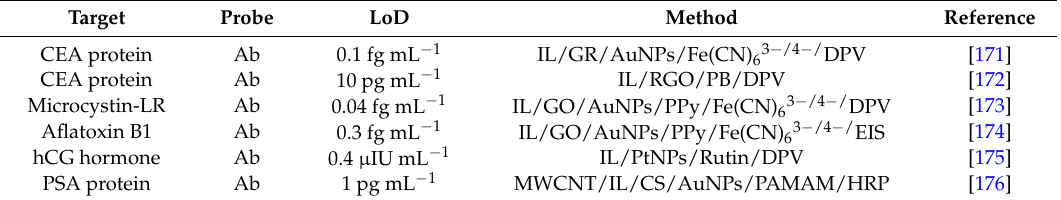
Table 11. Figures of merit of selected immunosensors using ionic liquids.